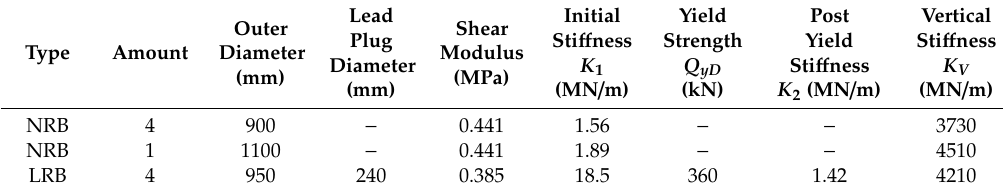
Table 4. Properties of selected isolators for Model-14.